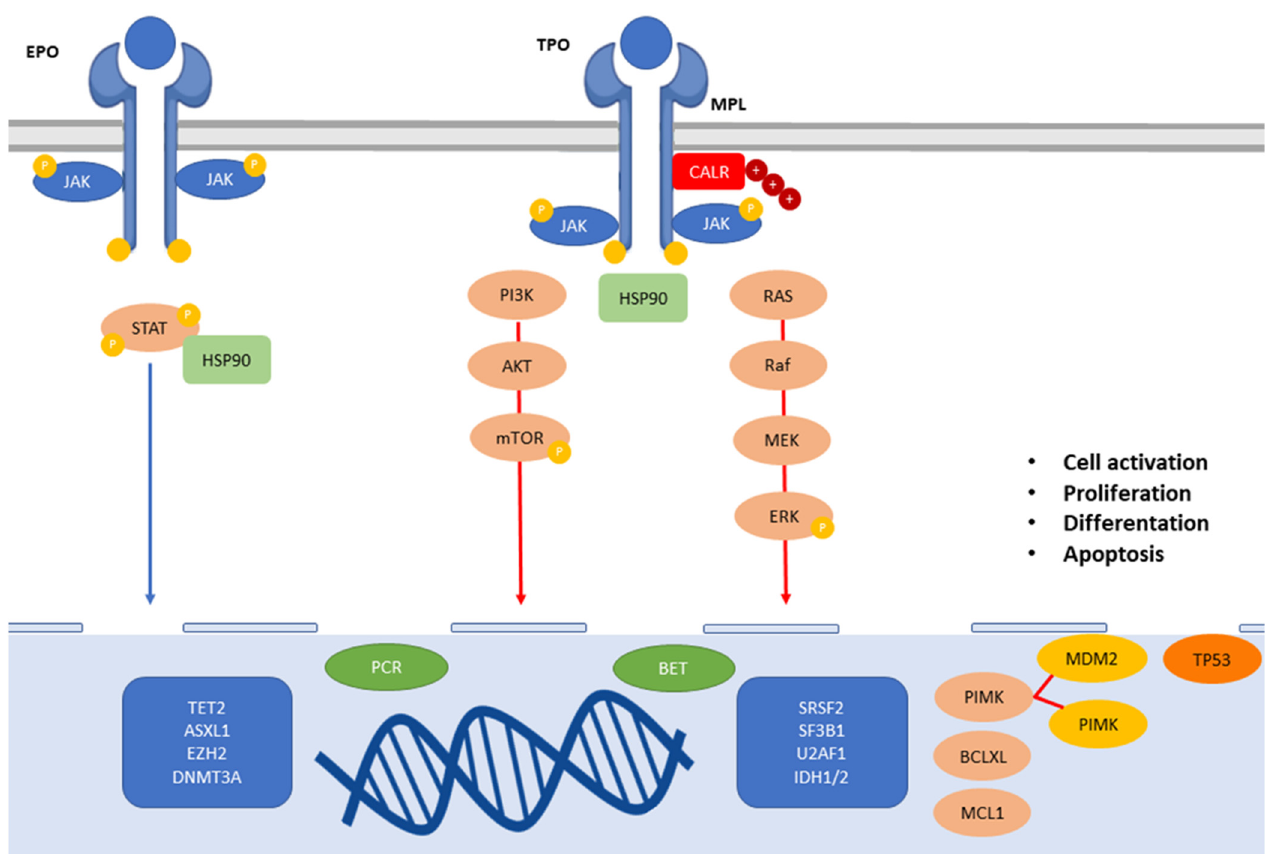
Figure 1. Signaling pathways involved in the pathogenesis of MPNs . The complexity of MF disease biology, involving intracelluar proliferative pathways, epigenetic events, HSC maintenance, differentation, and survival mechanisms, leads to the development of different therapeutic approaches.